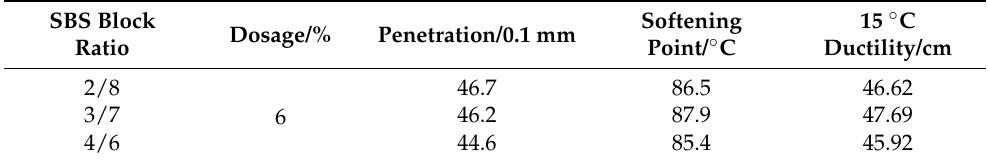
Table 7. Three indicators of asphalt modified by SBS with different block